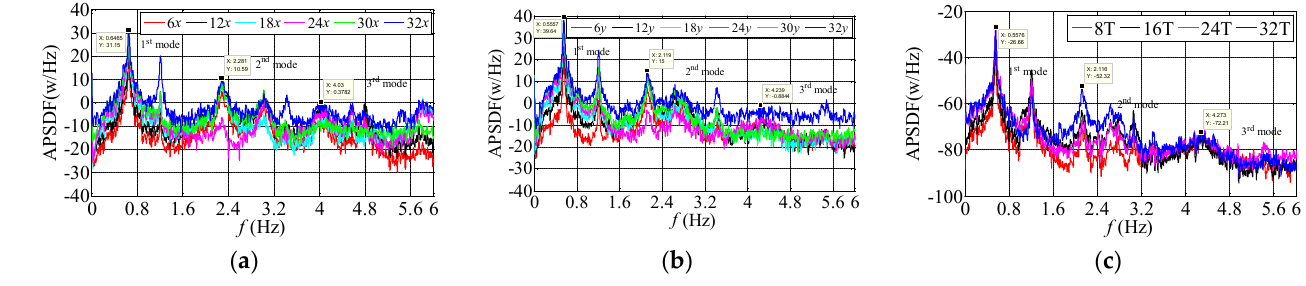
Figure 13. The measured APSDF when U 10min = 20.02m/s. ( a ) APSDF along x -axis; ( b ) APSDF along y -axis; ( c ) APSDF along torsional direction.